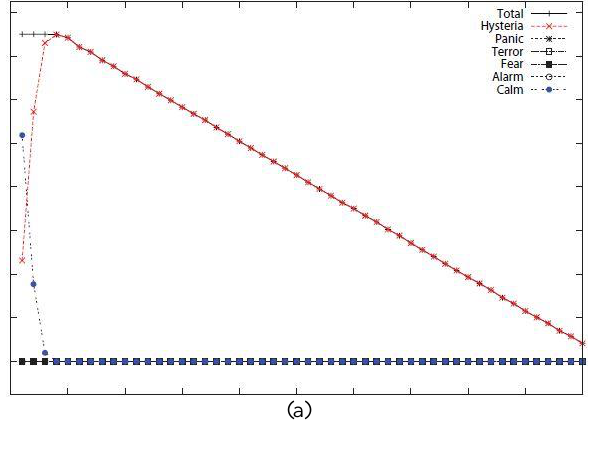
Table 1. Initialize counts of agents in scenarios Four initialized scenarios are run with different counts of agents that are presented above. Figure 3 shows the leaving diagrams for each scenario.